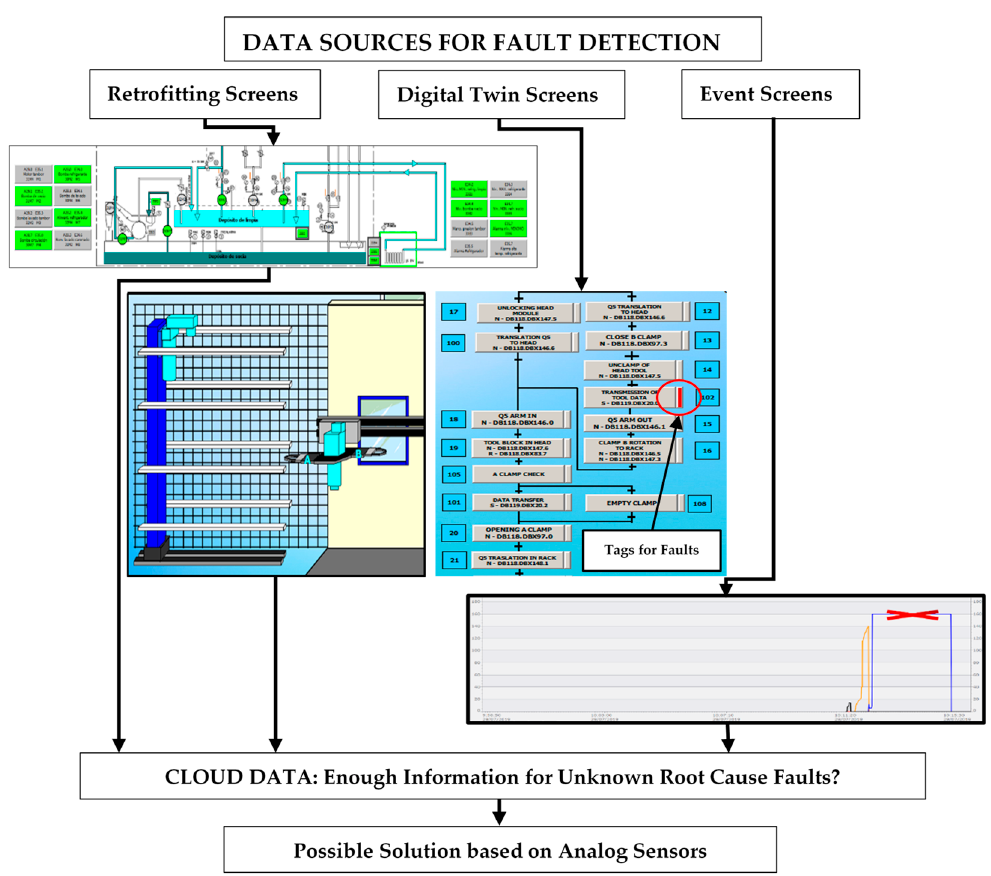
Figure 5. Standard data sources for fault detection.